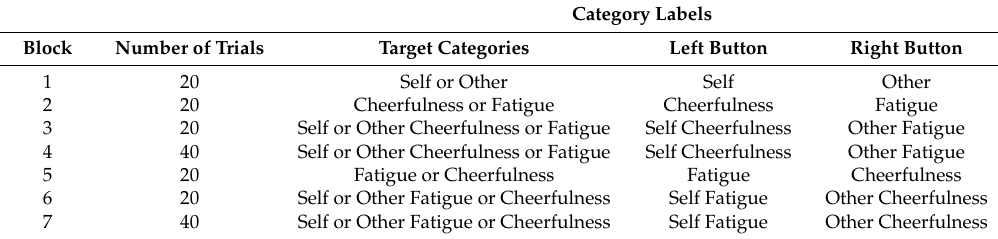
Table 1. Number of trials, target categories, and corresponding button mapping in each block. Participants categorized, as quickly and as accurately as possible, whether the central target word belongs to the category label in the upper-left or the one in the upper-right by clicking the corresponding button of a mouse. If a target word was applicable to the upper-left category label (upper-right category label), they clicked the left (right) button on the